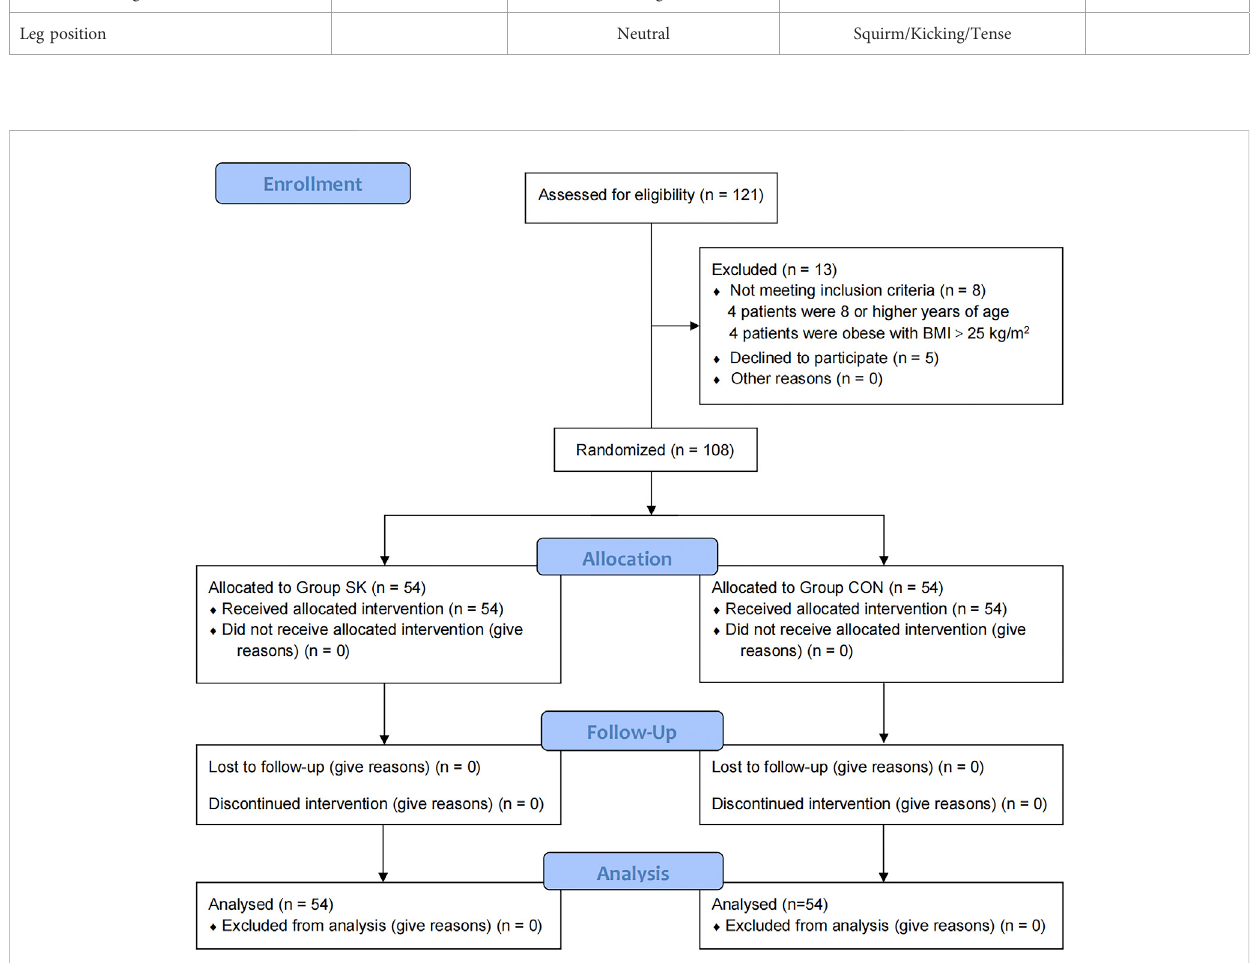
FIGURE 1 Consolidated Standards of Reporting Trials fl ow diagram of participants through each stage of the randomized